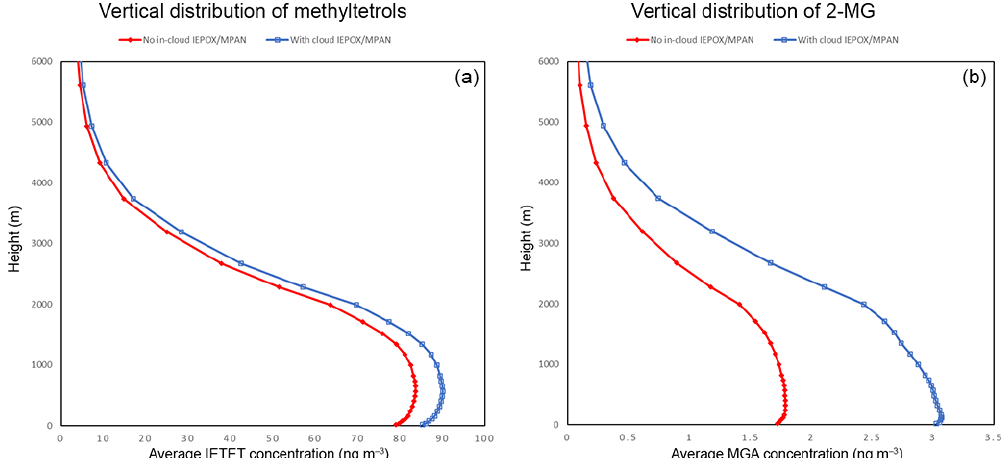
Figure 8. June 2013 vertical distribution of (a) 2-methyltetrols (ngm − 3 ) and (b) 2-MG (ngm − 3 ) , averaged spatially over the area indicated by the blue box in Fig. 6a.